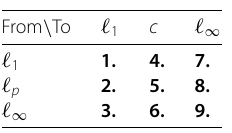
Table 1 The characterization of the class ( X , Y )